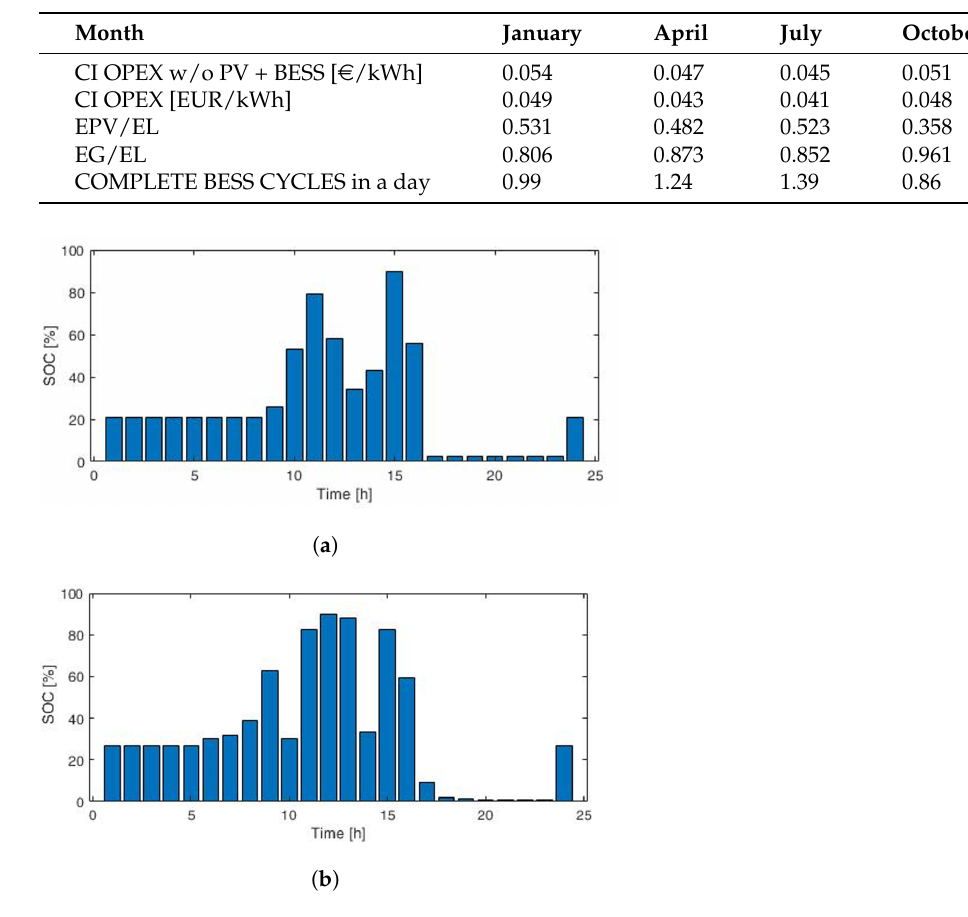
Figure 9. Optimal SOC distribution for SOCM model of a CI with 33.5 kW PV and 12.5 kWh BEES for: ( a ) January, ( b ) July. Table 5. Average yearly figures for LM OPEX with different BESS life cycles, and for SOCM